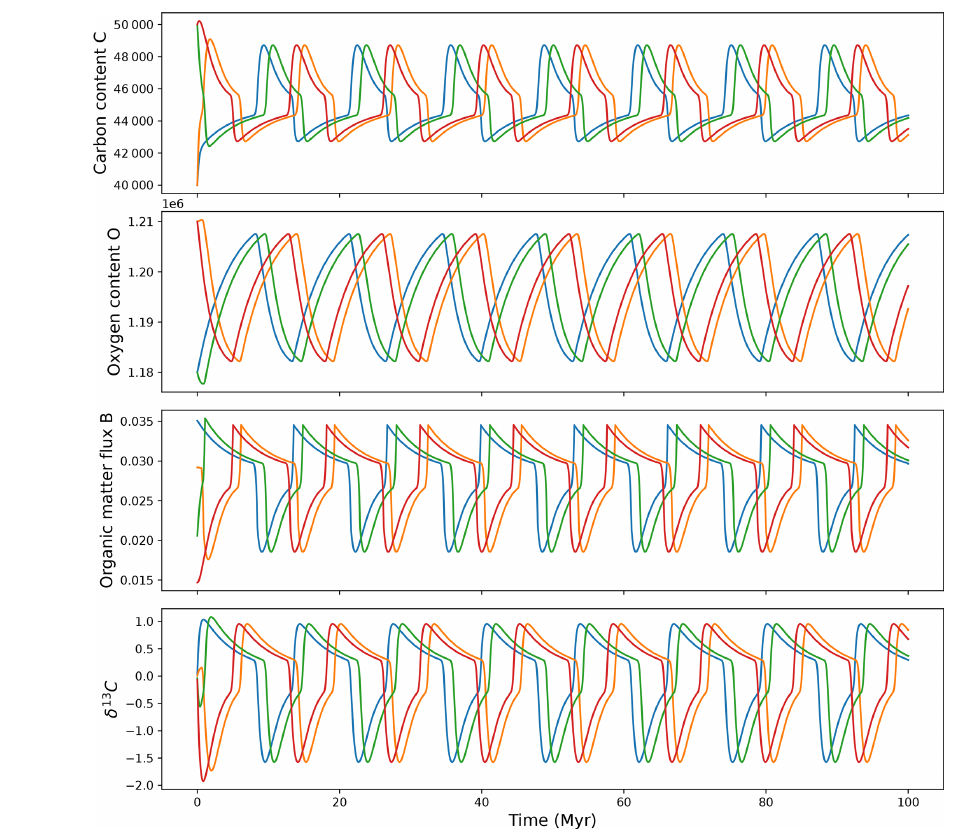
Figure 5. Modelled carbon content, C; oxygen content, O; organic matter flux, B ; and δ 13 C evolution in the case without astronomical forcing for different initial states. Case a < a lim